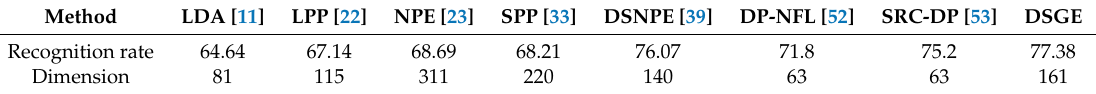
Table 1. The recognition rate and the corresponding dimension of each method on the AR databases.